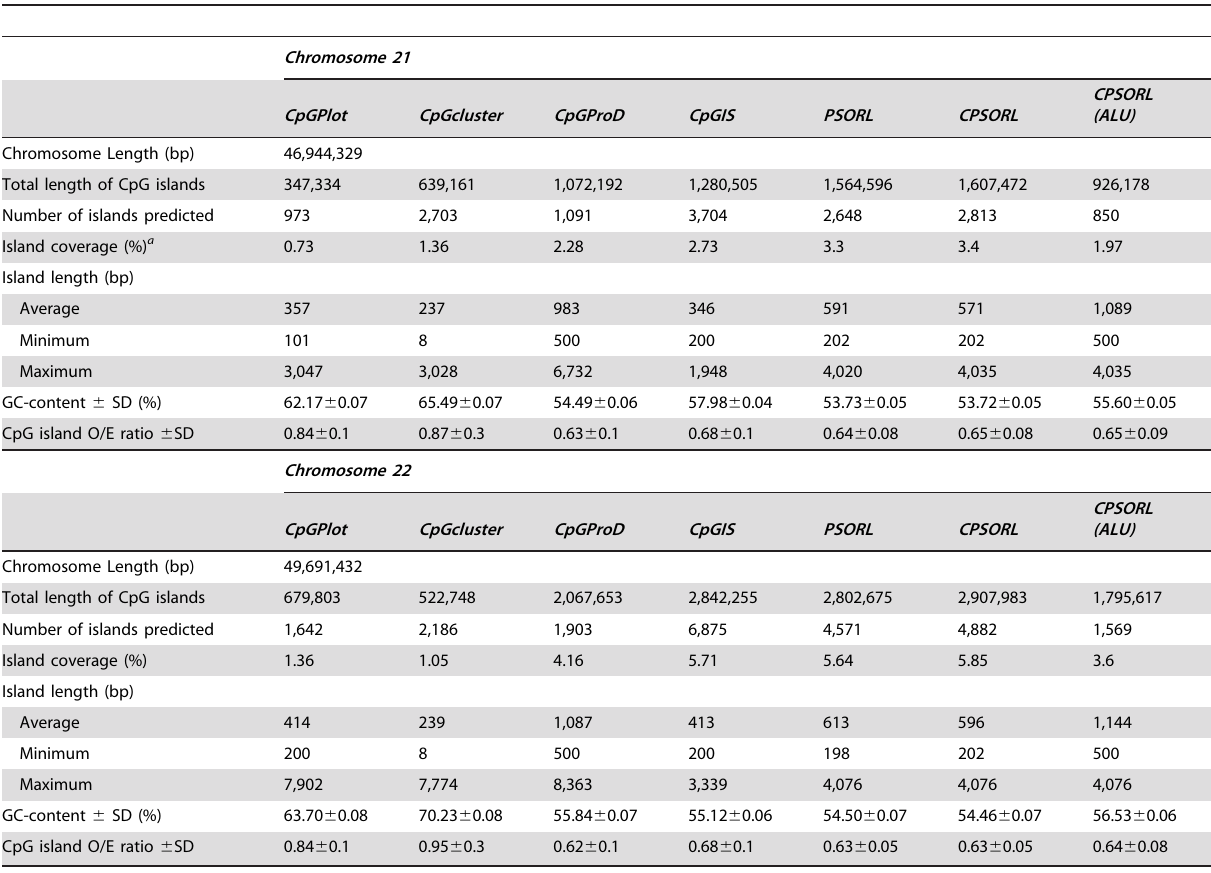
Table 3. Comparison of the number of CpG islands identified in the human genome with different methods. (NCBI.36)